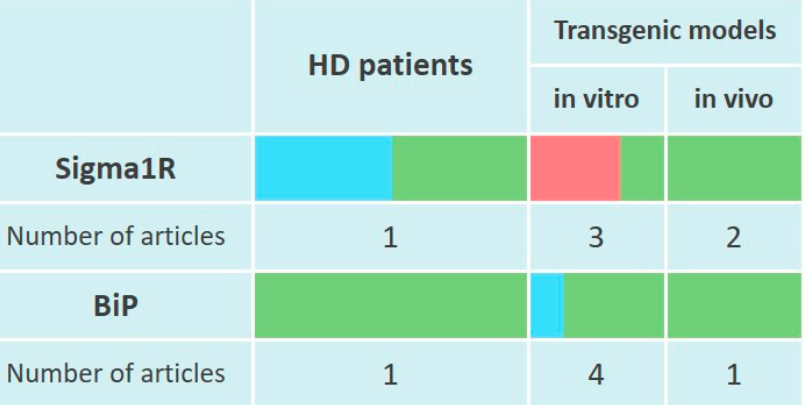
Figure 4. Changes of Sigma1R and BiP chaperones expression in the pathogenesis of Huntington’s disease. The table reflects experimentally recorded changes in the expression of Sigma1R and BiP chaperones, denoted in relative units, according to Sections 6.1 and 6.2. To visualize mRNA or protein levels following markers were used: green—content increased, blue—content did not change, red—content decreased.